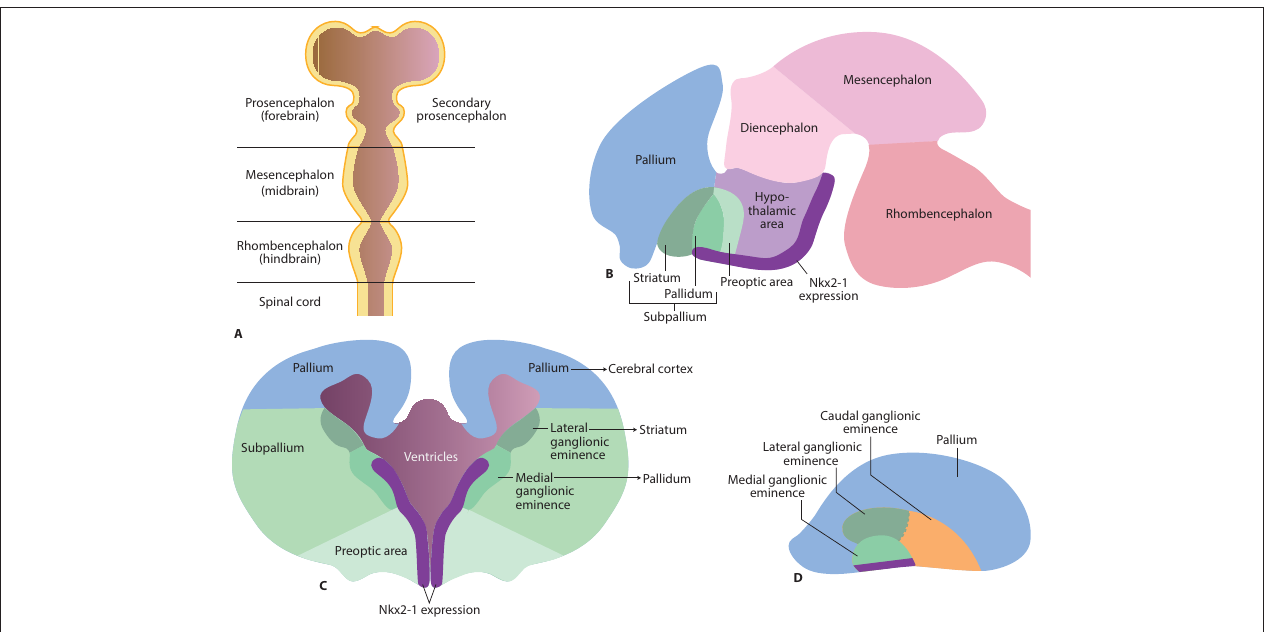
FIGURE 1 | Early brain development and Nkx2-1 expression in the early embryonic brain. (A) Brain vesicles and divisions in the mammalian brain corresponding to gestational day 33 in humans. (B) Nkx2-1 is expressed as a longitudinal band in the ventral secondary prosencephalon from the rostral pallidum to the caudal hypothalamic area (rodent brain E15, corresponding to gestational day 49 in humans). (C) Future basal ganglia develop from subcortical parts of the telencephalon (“subpallium”). The striatum develops from the lateral ganglionic eminence, and pallidum from the medial ganglionic eminence. (D) Side view illustrating the medial, lateral, and caudal ganglionic